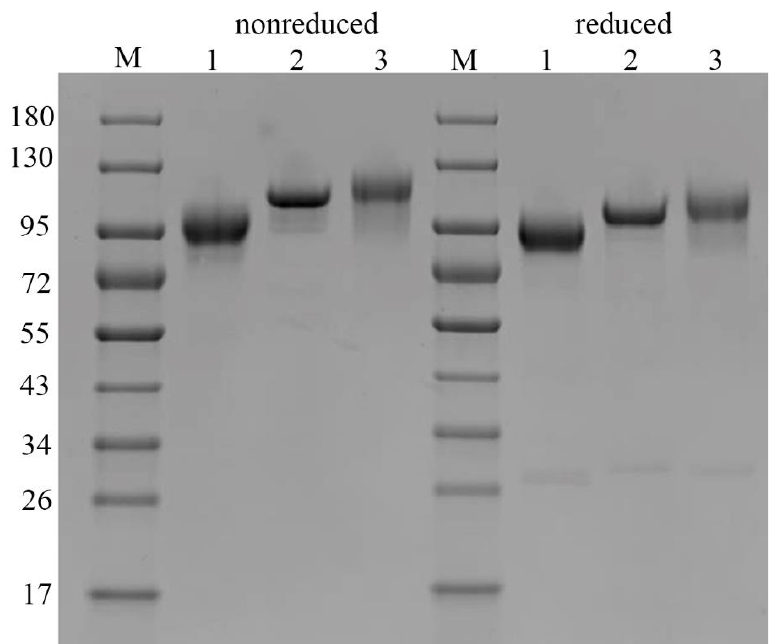
Figure 4. Electropherogram of the various C1 inhibitor molecules under non-reduced (on the left) and reduced (on the right) conditions. #1 — Ruconest ® , #2 — Berinert ® , #3 — rhC1INH, M — molecular weight markers (kDa).